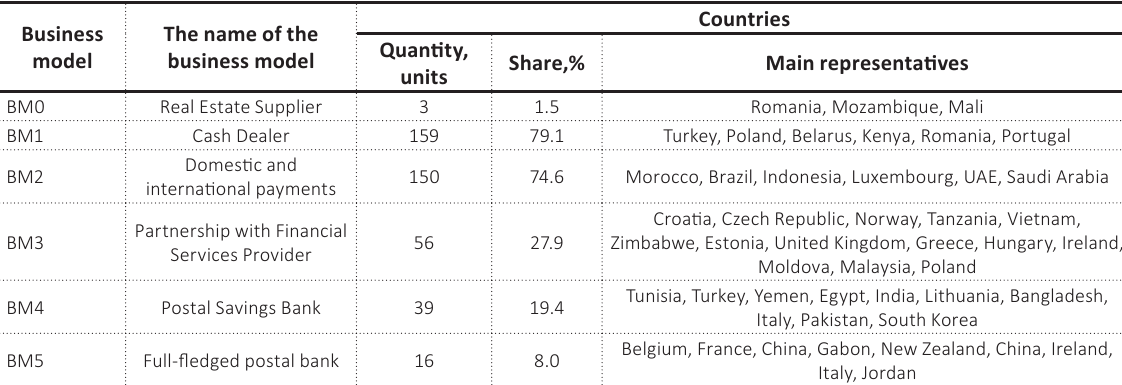
Table 3. Types of business models for postal